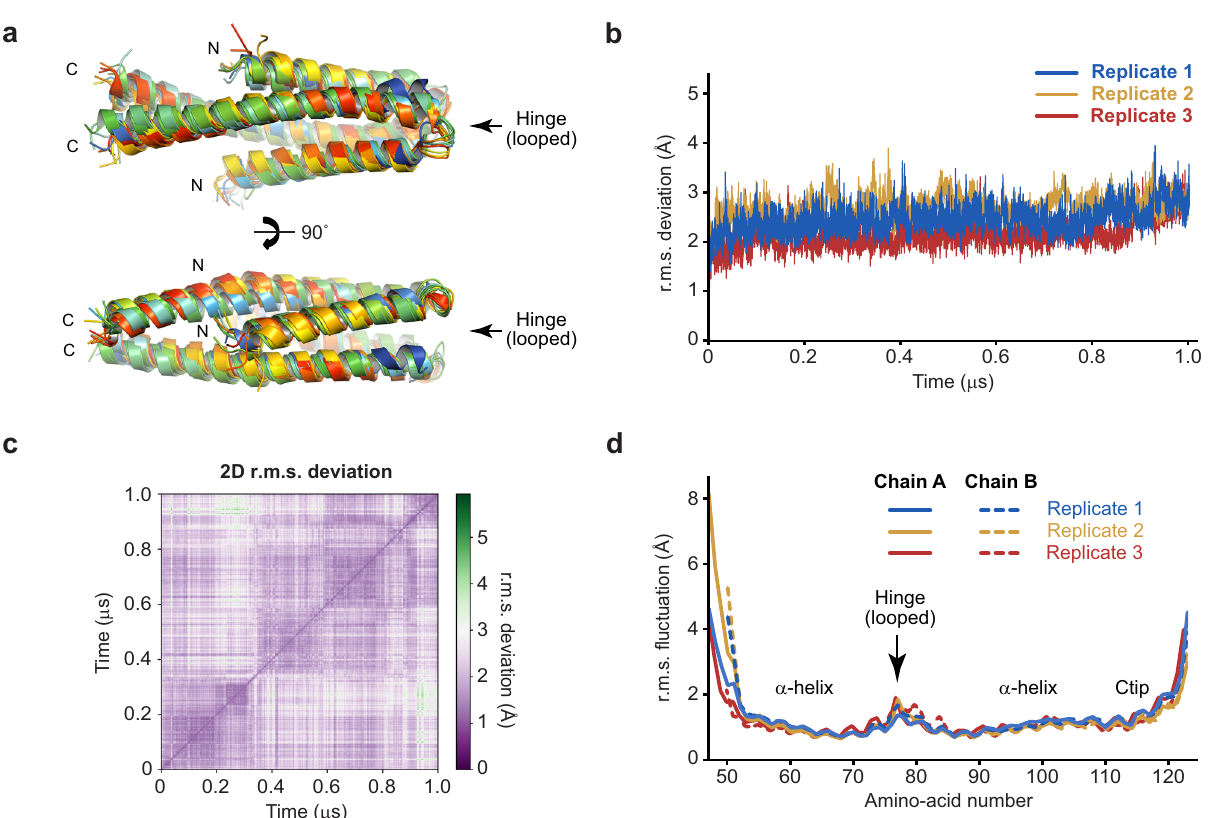
Fig. 7 Molecular dynamics simulations of the TEX12 compact dimer structure. a – d Analysis of the TEX12 compact dimer structure across 1- μ s molecular dynamics simulations performed at 37 °C ( n = 3). a Superimposed TEX12 compact dimer structures at 100-ns intervals of a representative trajectory, coloured from blue (0 ns) to red (1 μ s). b Overall r.m.s. deviations and c 2D r.m.s. deviations (corresponding to panel a ) across 1- μ s trajectories (2D r.m.s. deviations for the remaining replicates are shown in Supplementary Fig. 6). d Individual amino-acid r.m.s. fl uctuations following 1- μ s trajectories, shown for both chains of the dimer (solid and dashed), and indicating the positions of the α -helices, looped hinge and